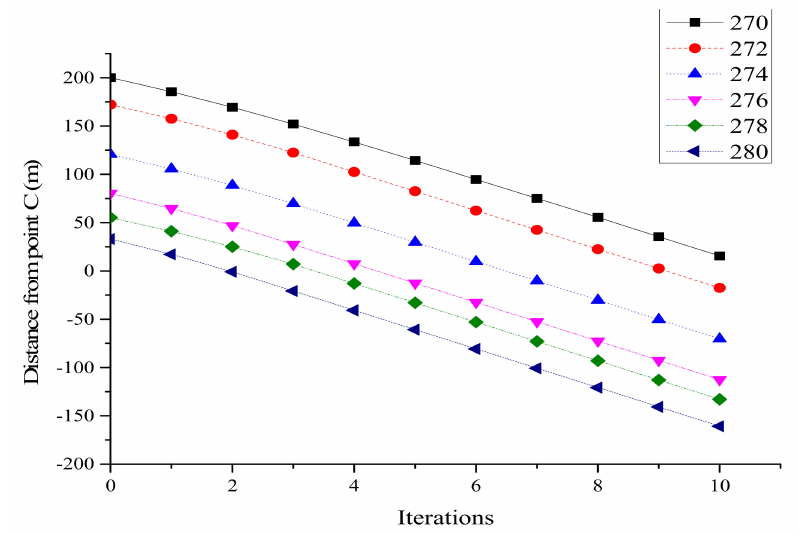
Figure 5. Distance from point C on lane